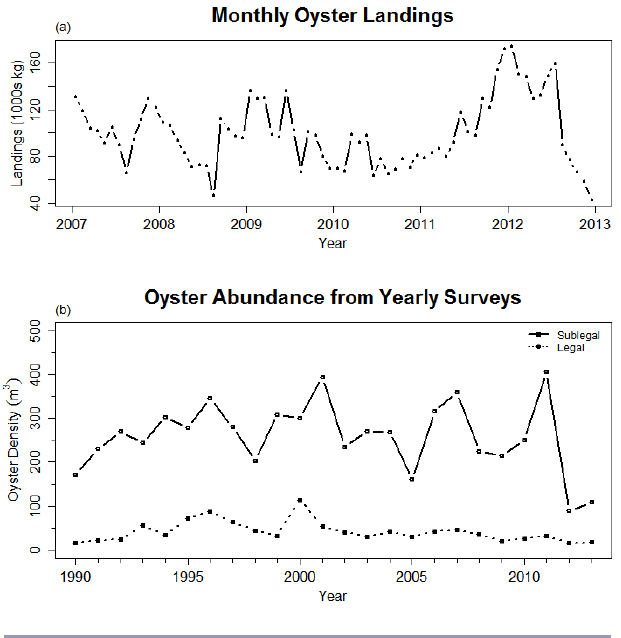
Fig. 4 . Monthly landings (a) data from the Florida Fish and Wildlife Conservation Commission, indicating reported amounts of oysters ( Crassostrea virginica ) harvested in 1000s kg/month, and oyster abundance from Florida Department of Agriculture and Consumer Services fisheries-independent surveys of oyster bars (b), indicating densities of both legal (> 7.6 cm) and sublegal sized oysters (m2/month). In both panels, the 2012 data are